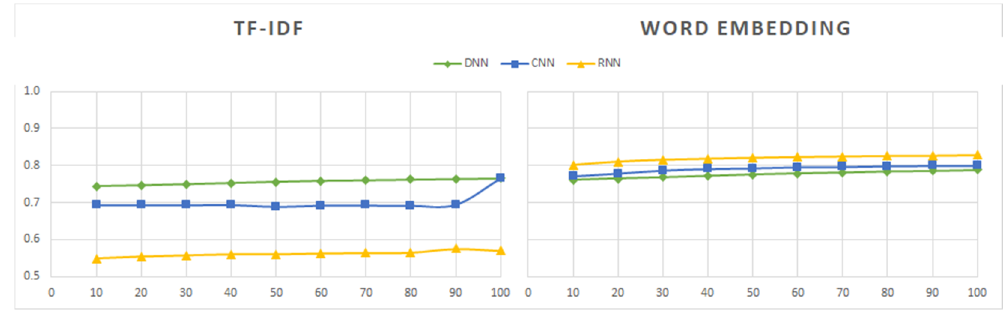
Figure 14. AUC values of DNN, CNN, and RNN models with TF-IDF and word embedding for different numbers of tweets (percentage of the dataset).